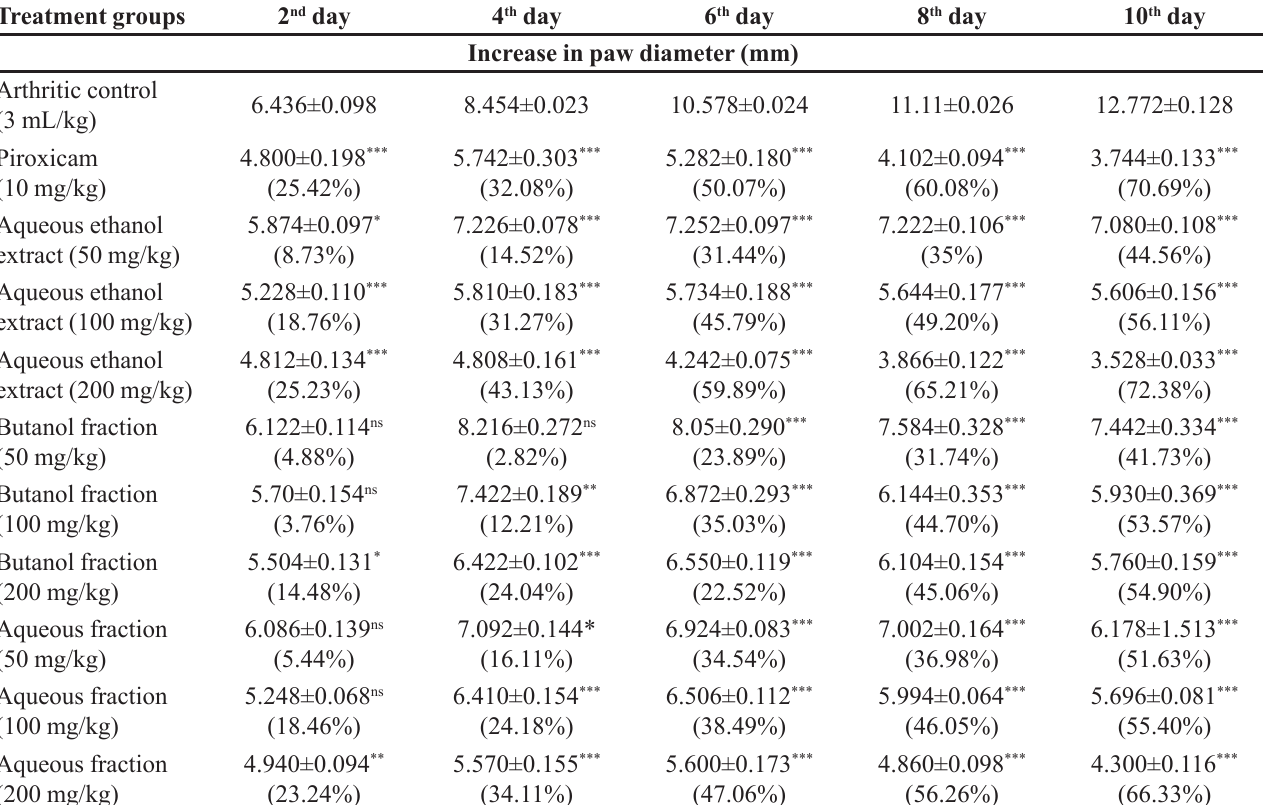
TABLE V - Effect of Ribes alpestre on Paw diameter in formaldehyde induced arthritis Treatment